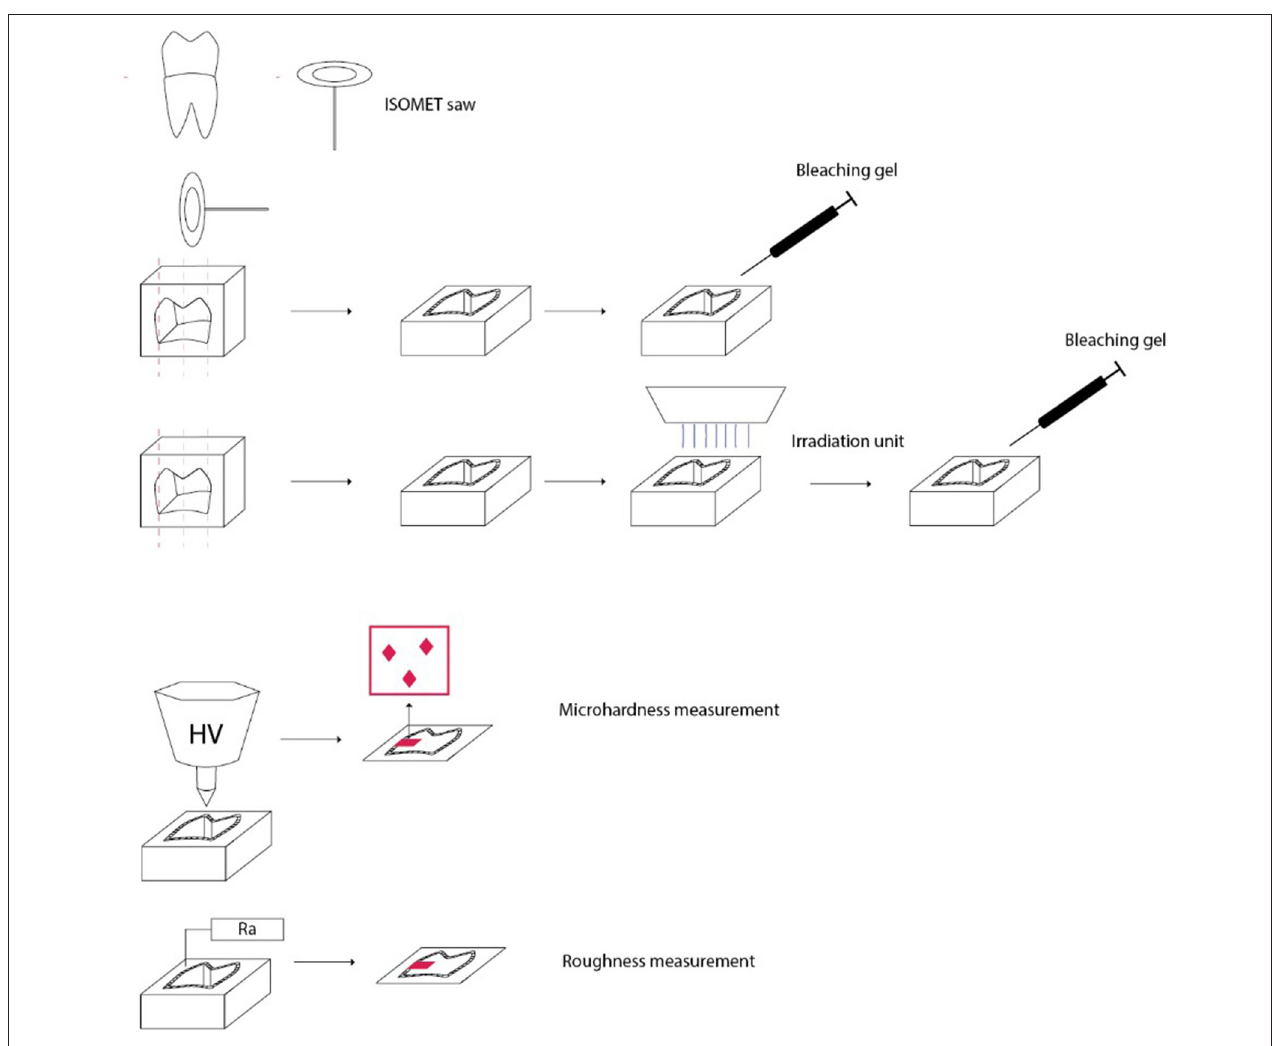
FIGURE 1 | Preparation of teeth samples, irradiation and bleaching procedures, and different measurement protocols.